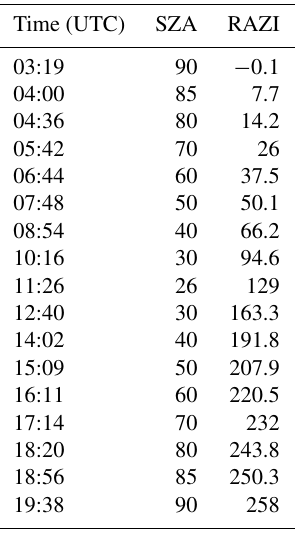
Table A2. Dependence of SZA and RAZI on time (UTC) for the standard viewing direction (51 ◦ with respect to